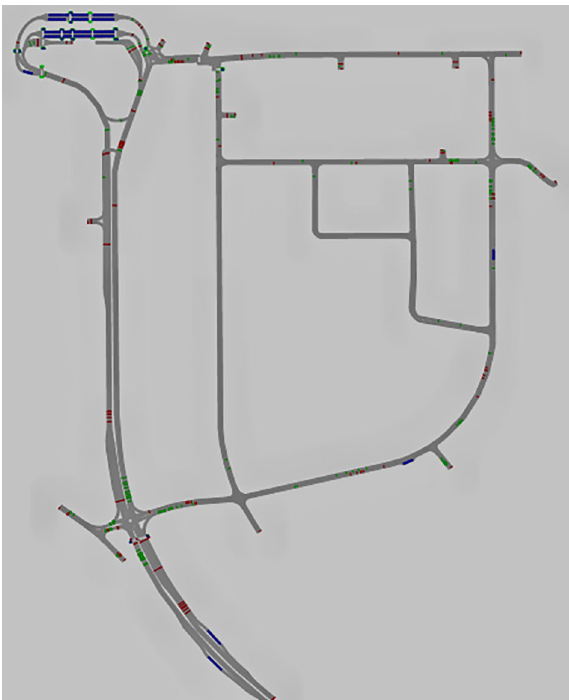
Figure 6. Network